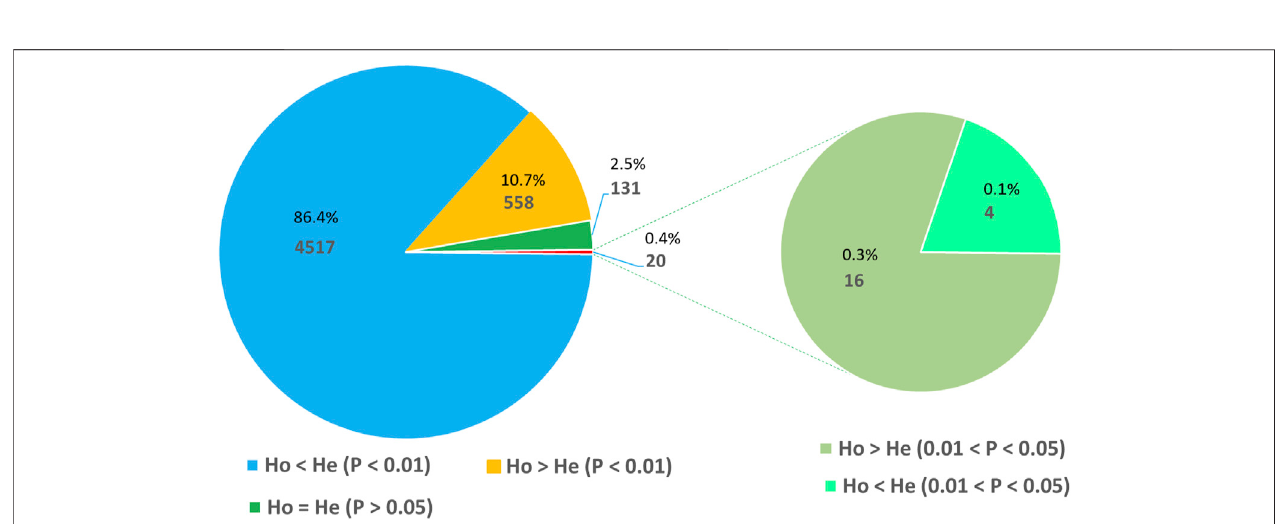
FIGURE 4 | Pie chart illustrating the number and proportion of SNP loci at Hardy – Weinberg equilibrium (HWE) and those with a signi fi cant deviation from HWE in terms of heterozygote excess and de fi ciency.